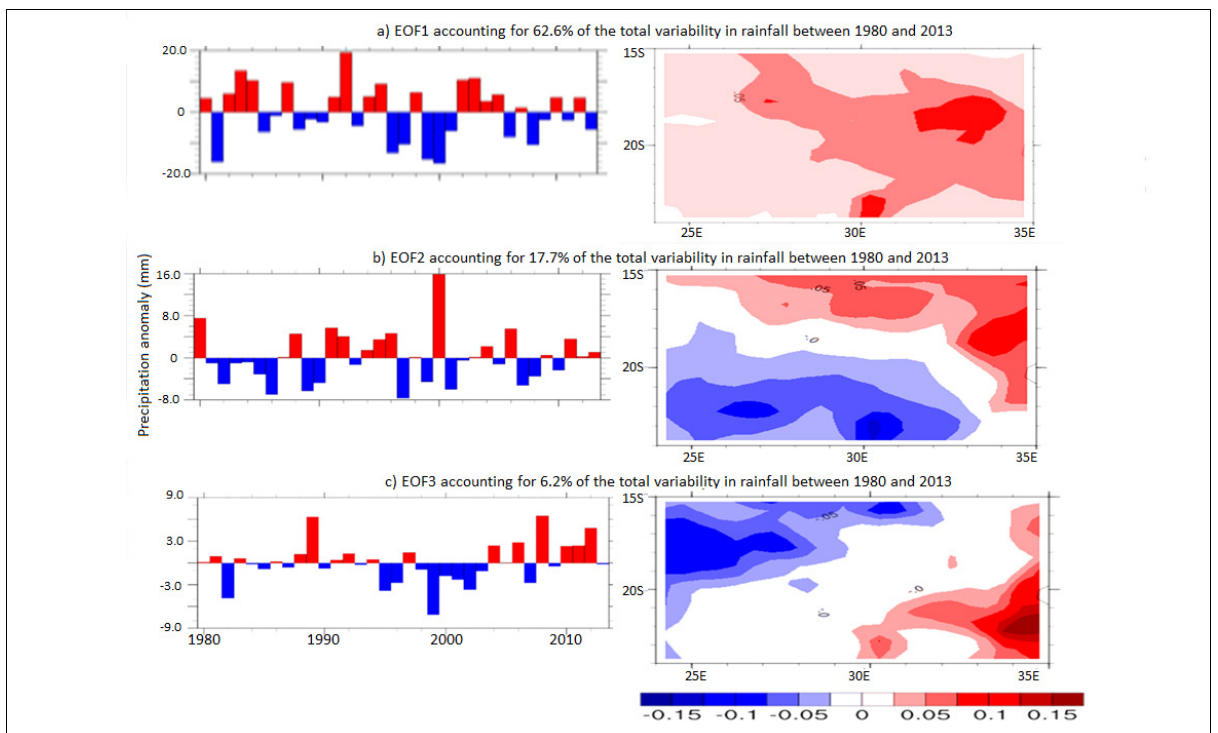
Figure 6: Time series and eigenvectors for the variability of Zimbabwean summer rainfall, 1980 to